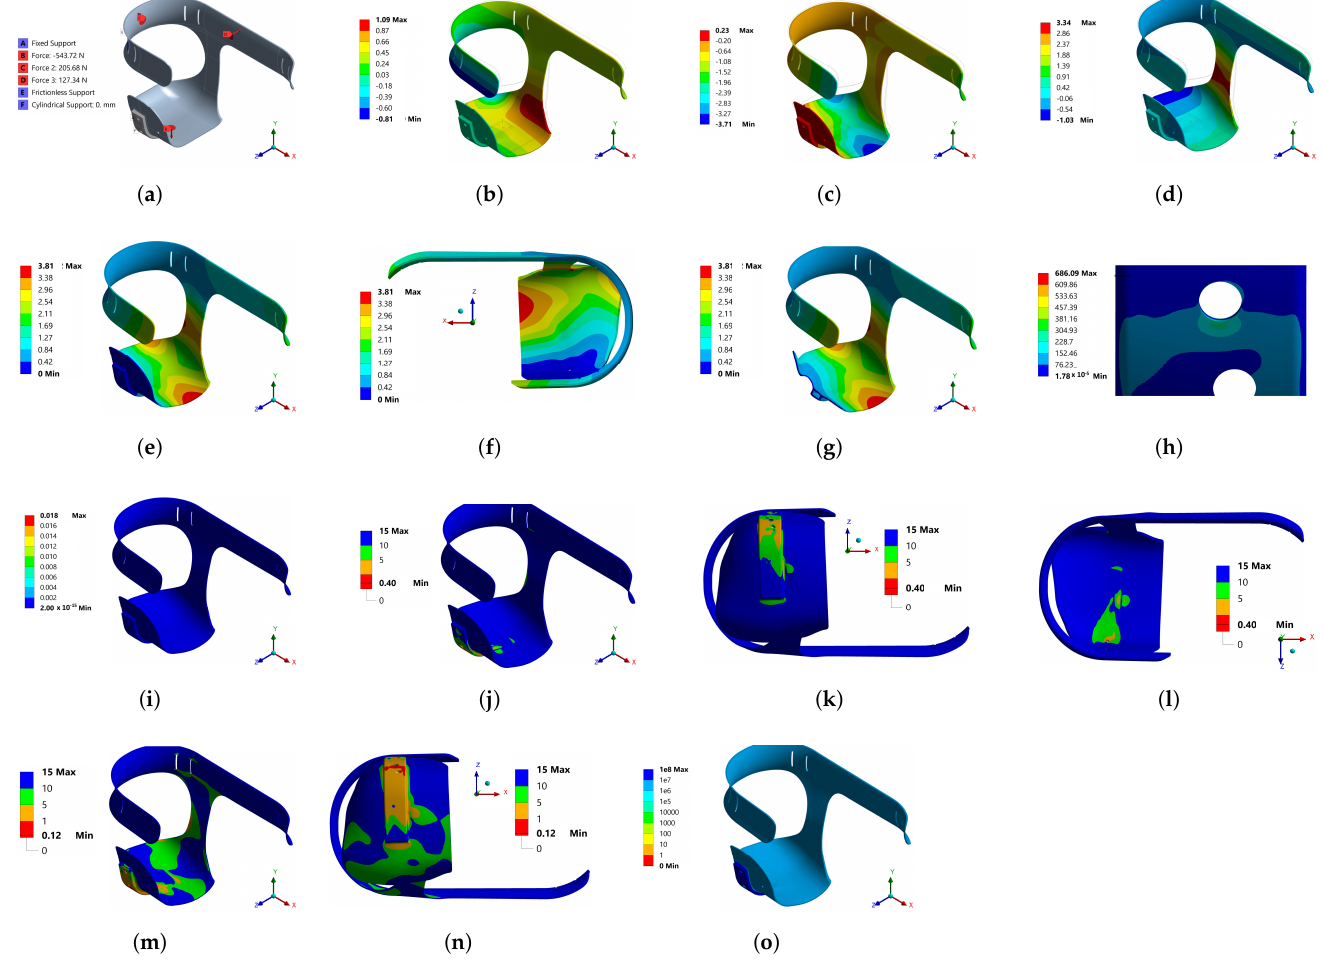
Figure 7. Mechanical behavior results for Model 3: ( a ) loads and supports; ( b ) directional deformation (mm) (x-axis); ( c ) directional deformation (mm) (y-axis); ( d ) directional deformation (mm) (z-axis); ( e ) total deformation (mm); ( f ) total deformation (mm), top view; ( g ) total deformation (mm); surfaces with greater deformation; ( h ) Von Mises equivalent stress (MPa), stress concentration; ( i ) structural error (mJ); ( j ) safety factor, static load; ( k ) safety factor, static load; ( l ) safety factor; static load; ( m ) fatigue, safety factor; ( n ) fatigue, safety factor bottom view; ( o ) fatigue,